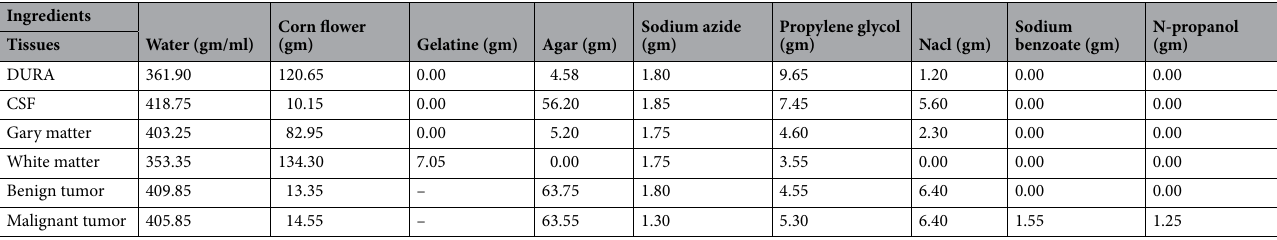
Table 4. Ingredients for 500 gm phantom/tissues fabrication.